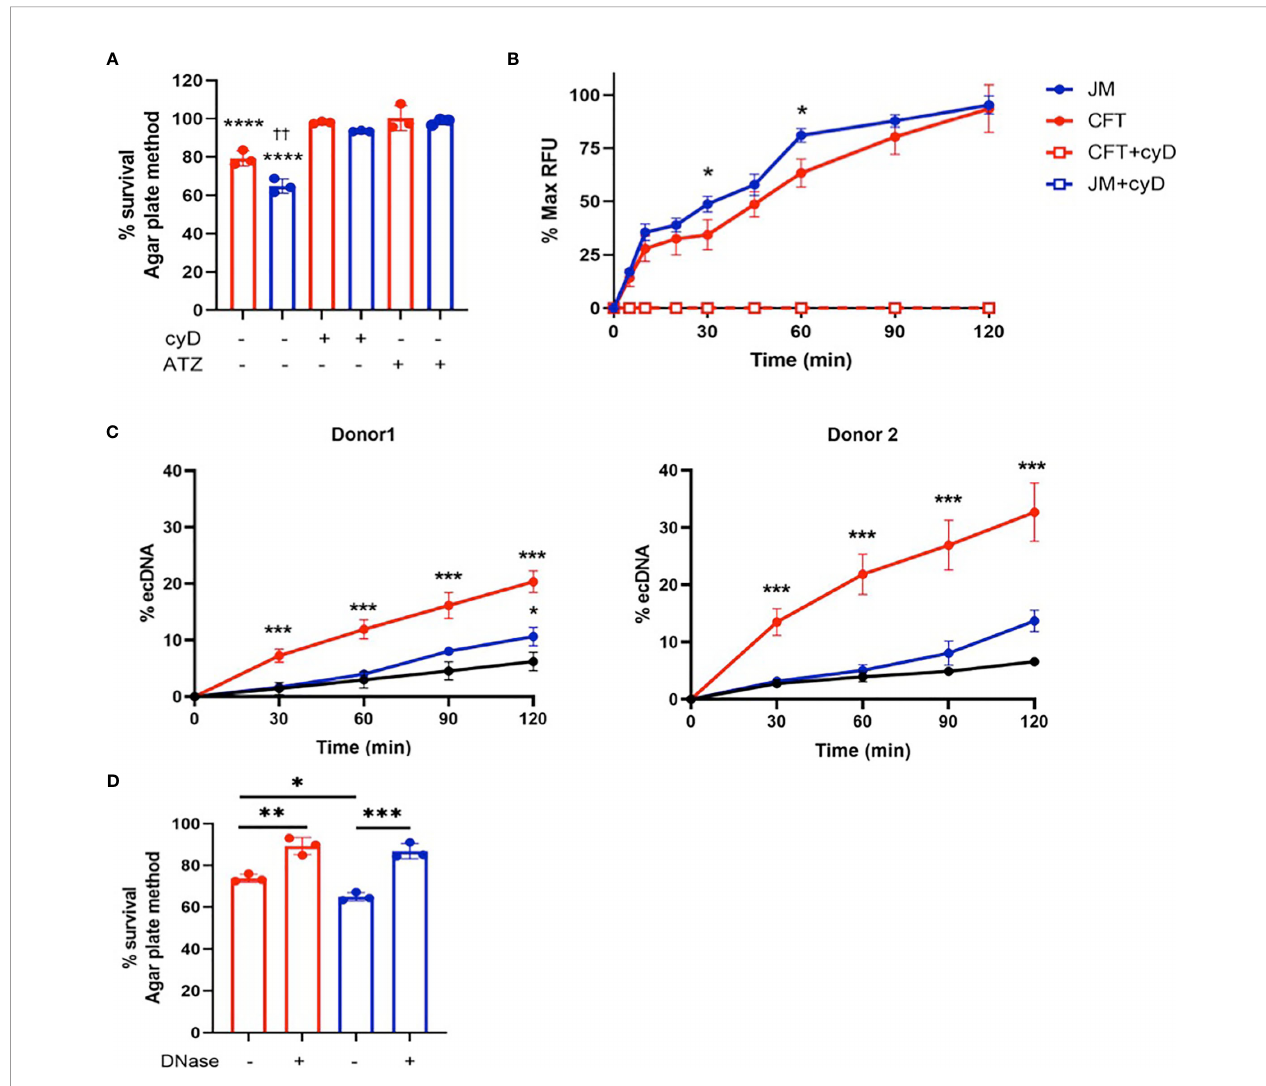
FIGURE 3 | Neutrophil killing mechanisms of E. coli . (A) 2x10 6 /ml of neutrophils were cocultured with either CFT073 (red) or JM109 (blue) at a ratio of neutrophil: E.coli 1:10 for 30min at 37°C. Some coculture experiments were performed with neutrophils pretreated with 10mM ATZ for 5min or 10µg/ml cyD for 15 min. Bacteria survival % was calculated compared to control bacteria. p-value: ****< 0.0001, comparison between each treatment versus 100% survival control. p-value: †† <0.01, comparison between neutrophil coculture JM109 and coculture CFT073 cells. (B) Neutrophils were cocultured with pH sensitive pHrodo deep red labeled CFT073 or JM109 at neutrophil: E. coli ratio of 1:10 as well as in the presence of cyD. Phagocytic response is graphed as % max RFU as described in “ Material and methods ” . cyD treated CFT073 (red open squares) and JM (blue open squares) data overlap in the graph. (C) ecDNA % was measured in the co-cultures and control neutrophils (black) in experiments with two different neutrophil donors by the Sytox green assay as described in “ Materials and Methods ” (mean ± SD, n=3). (D) 1x10 6 cells of either CFT073 or JM109 strains were incubated for 30 min with isolated 50ng/ml of NETs or NETs pretreated with 100U/ml DNase as indicated. Treatment condition with NETs was further incubated with 100U/ml DNase for 10 min prior to plating on LB plates. Bacterial survival (%) was calculated from CFU/ml relative to control bacteria not exposed to NETs. Values represent the mean ± SD for n=3. Statistics were performed using one-way ANOVA with Tukey ’ s multiple comparison test (A, C, D) and unpaired t-test for neutrophil coculture CFT073 versus JM109 in (B) p-value; ****< 0.0001; ***< 0.001; **< 0.01; * <